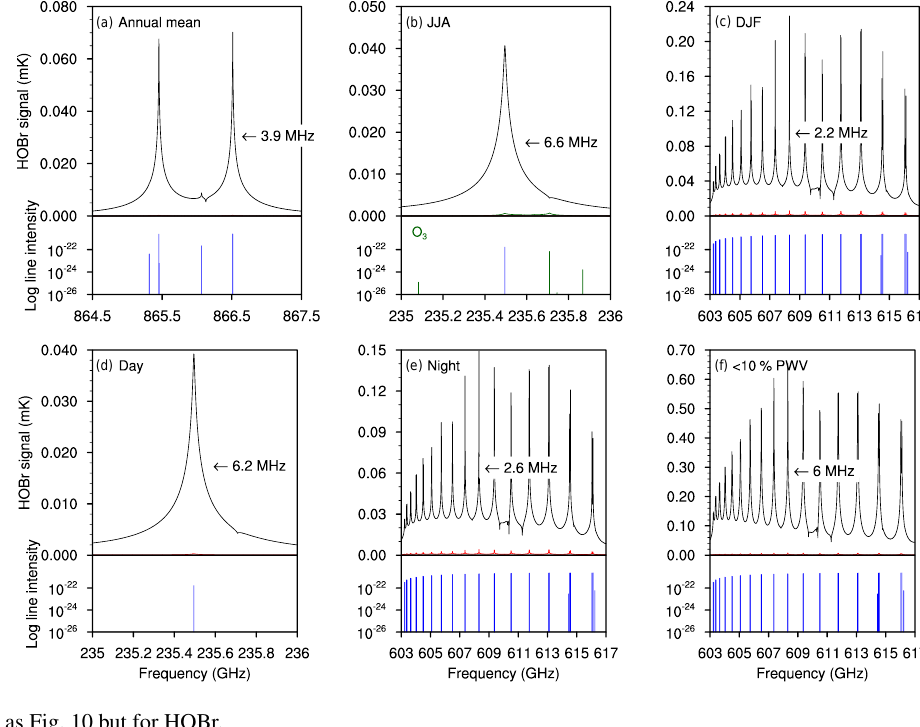
Figure 11. Same as Fig. 10 but for HOBr.